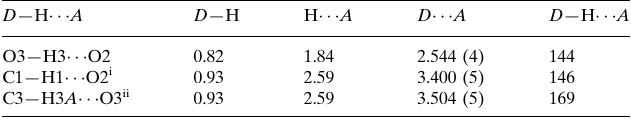
Hydrogen-bond geometry (A˚ , (cid:2)